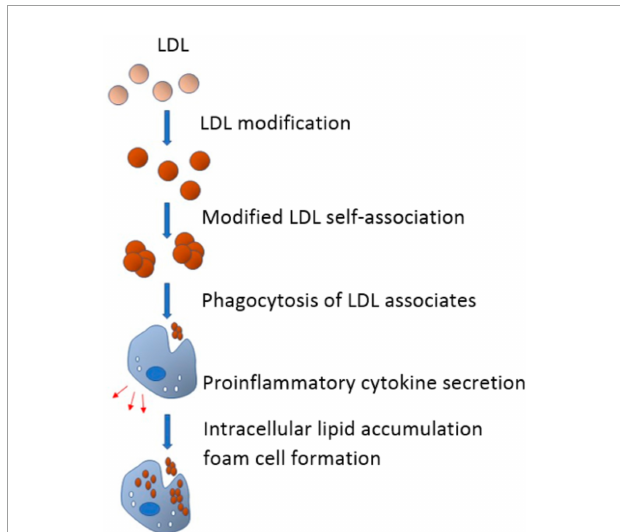
FIGURE1 In the blood flow, low-density lipoprotein (LDL) undergoes multiple modifications and acquires atherogenic properties. Modified LDL particles have a tendency to form self-associates that, in turn, promote phagocytosis of subendothelial arterial cells. Being triggered by phagocytosis, proinflammatory response emerges and pro-inflammatory cytokines are secreted. Pro-inflammatory cytokines promote or even cause the accumulation of intracellular lipids, which leads to the formation of foam cells (From